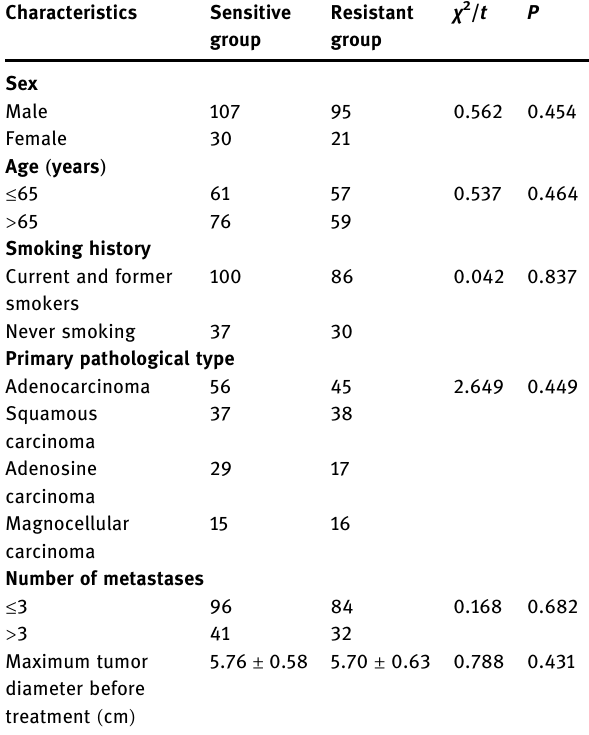
Table 1: Clinical characteristics of 253 patients with NSCLC and brain metastasis